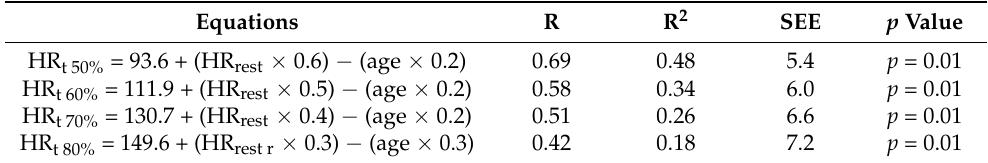
Table 2. Equations developed to estimate the intensities of 50, 60, 70 and 80% for the regression group (GR) having the HR/VO2 measured in a treadmill exercise test as the dependent variable. Equations R R 2